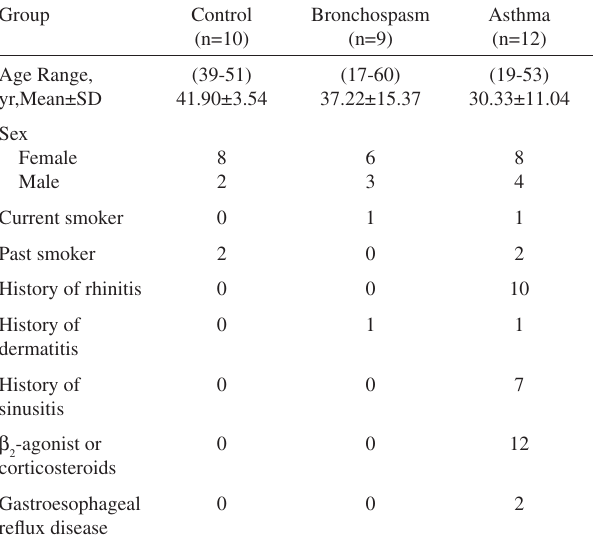
Table 1 - Subject